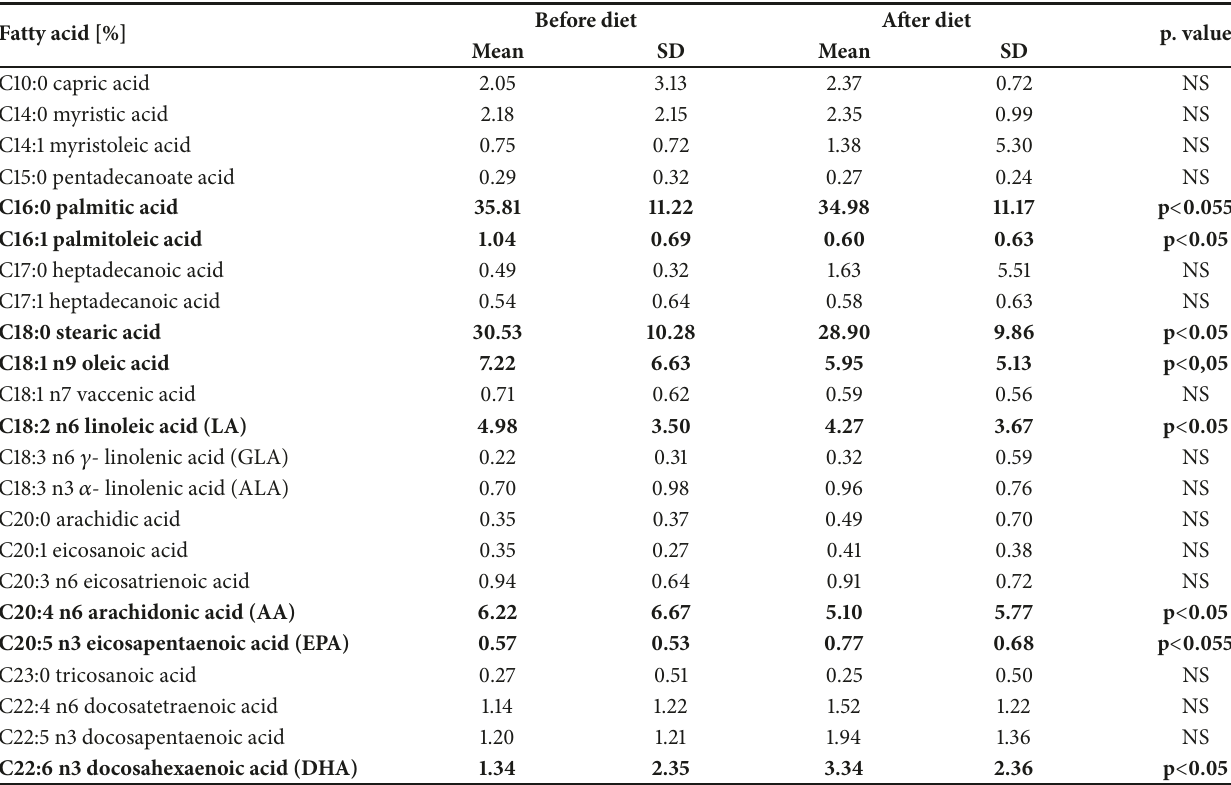
Table 4: The differences in the fatty acid profile before and after the dietary intervention.